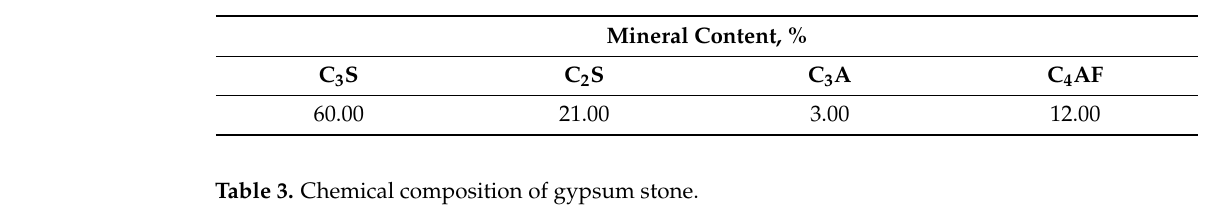
Table 2. Clinker mineralogical composition.